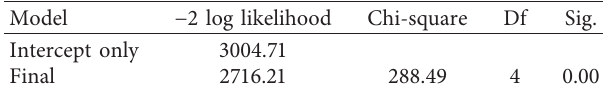
Table 6: Model fitting information.